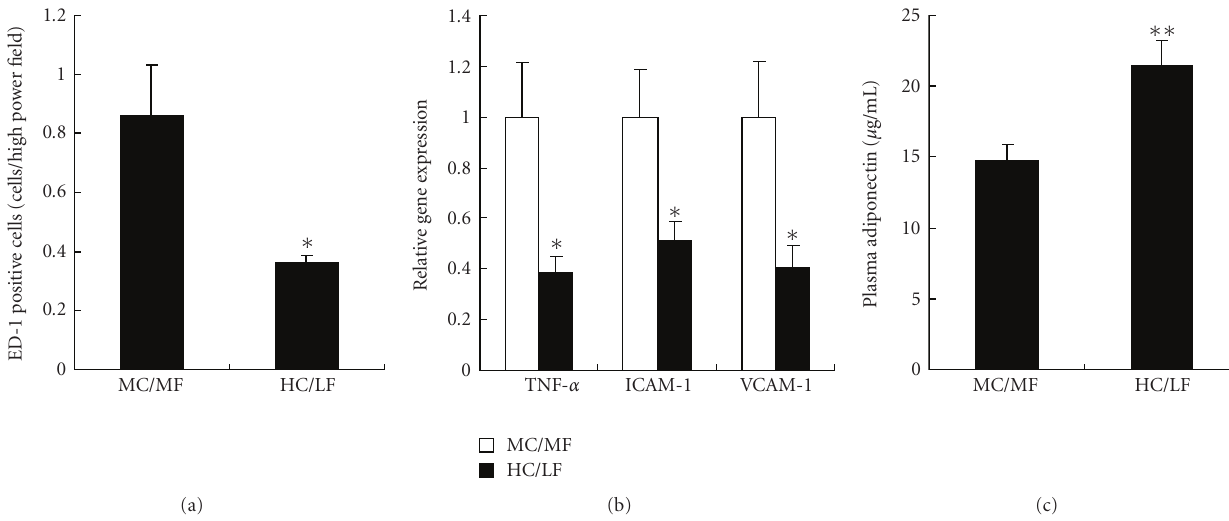
Figure 5: Inflammation in renal tissues. (a) ED-1 positive cells in tubulointerstitial area, (b) gene expressions of TNF-alpha, ICAM-1, and VCAM-1, and (c) plasma adiponectin level in MC/MF (white bar) and HC/LF (black bar). ∗ P < . 05, ∗∗ P < .